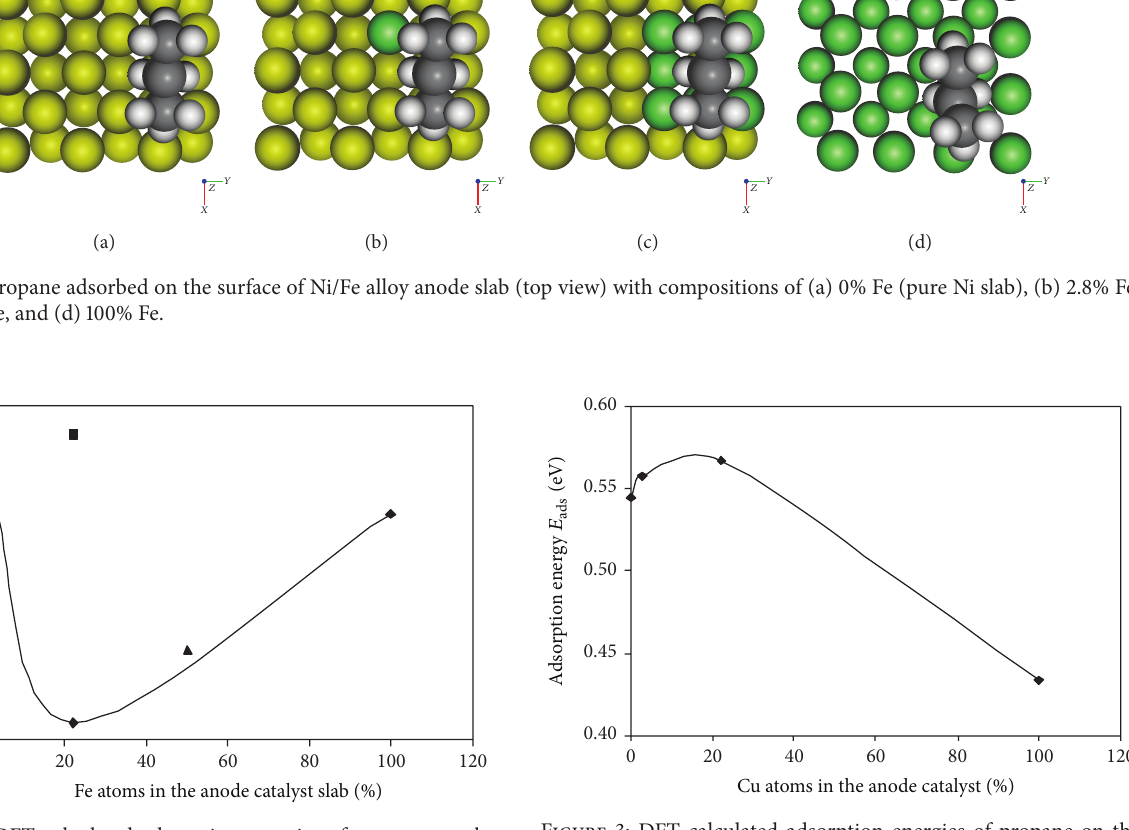
Figure 2: DFT calculated adsorption energies of propane on the surface of Ni/Fe alloy slabs with various compositions. The diamond shaped data points represent slabs having ordered structures. The triangular shaped datum point represents a slab containing 50%Ni and 50% Fe. The square shaped datum point represents a 22.2% Fe slab where the 8Fe atoms have arbitrary locations and are further from the Ni adsorption site.